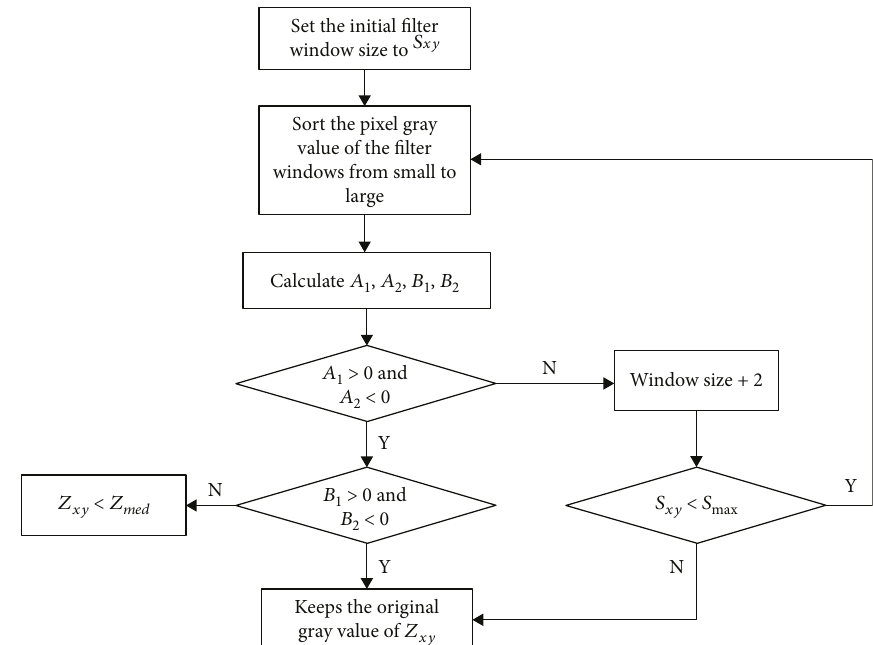
Figure 3: Adaptive median fi lter fl ow